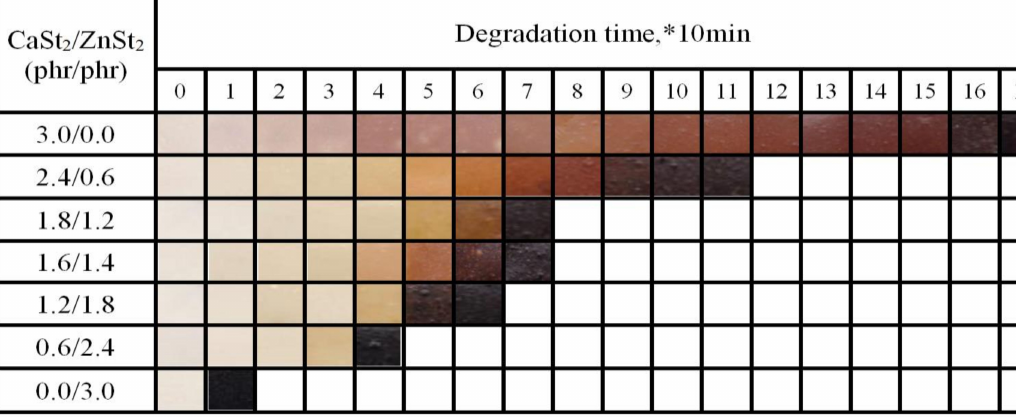
Figure 11. The effects of discoloration for PVC with different proportion of CaSt 2 /ZnSt 2 thermal stabilizers at 180 ◦